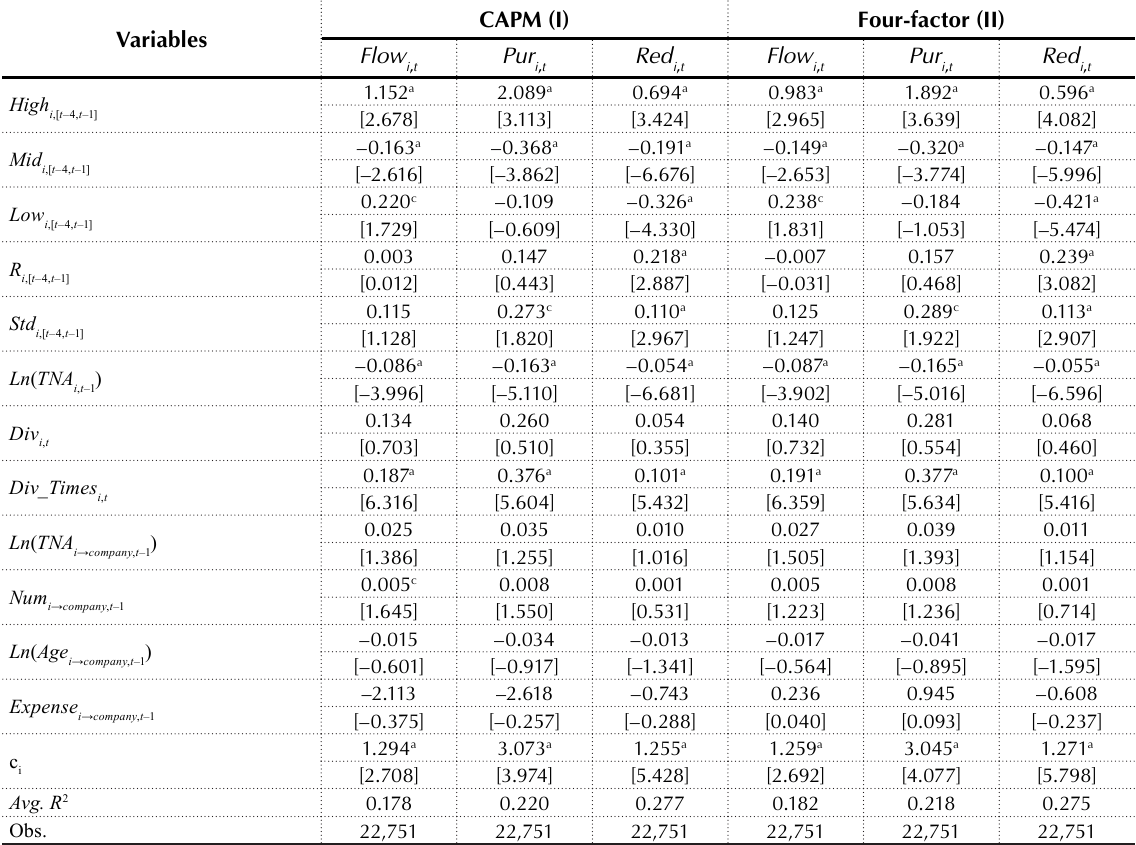
Table 5. Robustness test: the adoption of CAPM alpha and four-factor alpha